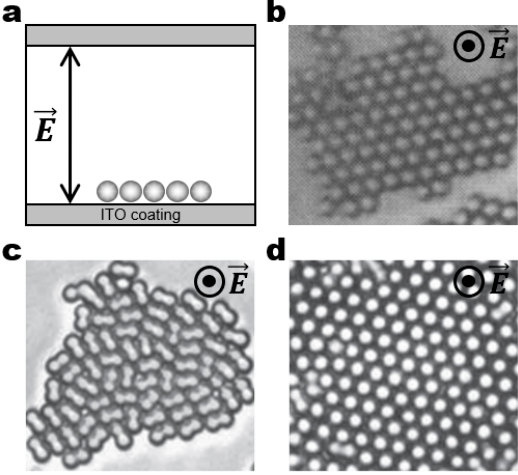
Figure 4. Field-driven dynamic structuring in a vertical electric field with low frequency and high salt concentrations. ( a ) Schematic of the experimental setup for a vertical AC electric field along the z -direction. An AC electric field is applied between indium tin oxide (ITO)-coated electrodes. Upon application of the low-frequency field, the dispersed particles adjacent to the bottom electrode experience EHD attraction, leading to their self-assembly. ( b ) Assembly of 2 µ m polystyrene particles into crystalline structures. Reproduced with permission [48]. Copyright 1996, American Association for the Advancement of Science. ( c , d ) Assembly of symmetric dimers (~1.5 µ m × ~2.8 µ m) into close- packed structures. Reproduced with permission [49]. Copyright 2012, Wiley. ( c ) The close-packed structure of lying dimers at the field frequency of ~0.6 kHz. The dominant hydrodynamic torques align the dimers parallel to the bottom surface. ( d ) The close-packed structure of standing dimers at the field frequency of ~6 kHz. Each dimer appears as a circle because of the dominant electric torque aligning the long axis of the dimers along the field direction. The circle and dot with the electric field denote that the field is applied perpendicular to the plane of view in ( b – d